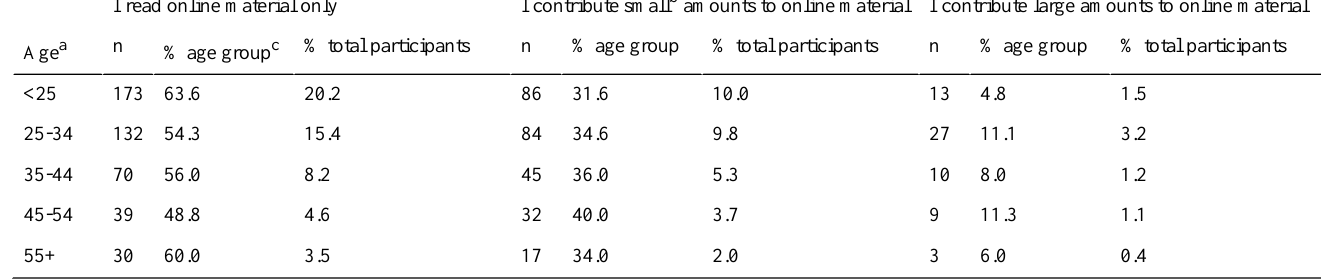
Table 3. Contribution to online material for professional purposes by